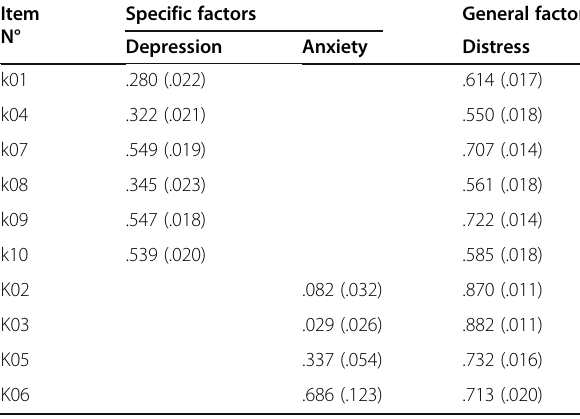
Table 2 Confirmatory factor model estimated for the Brazilian version of the